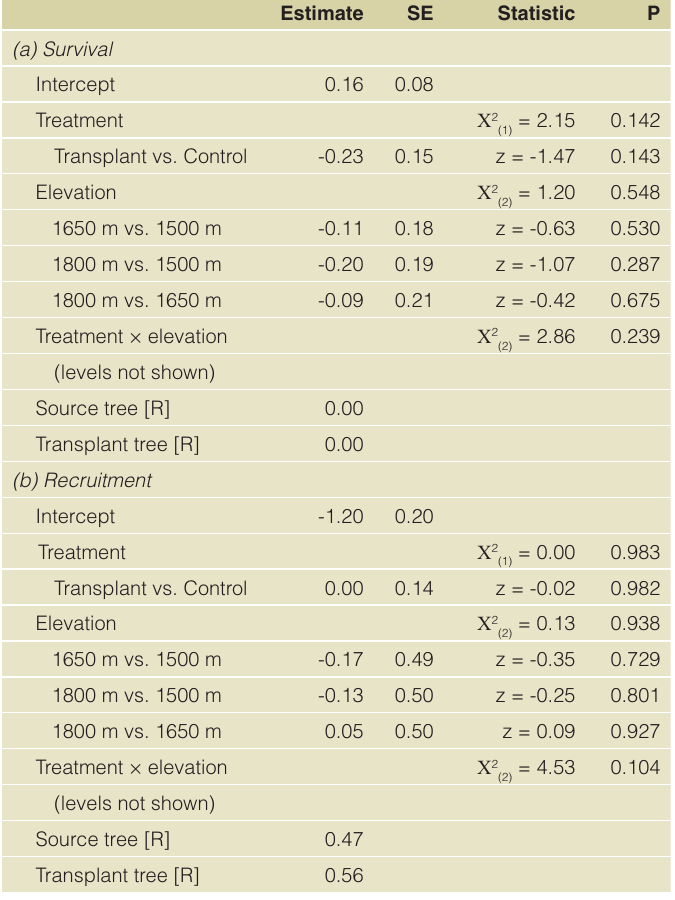
Table 3. Results of generalized linear mixed-effects models (GLMMs) for all species in mats transplanted within elevations. SE: standard